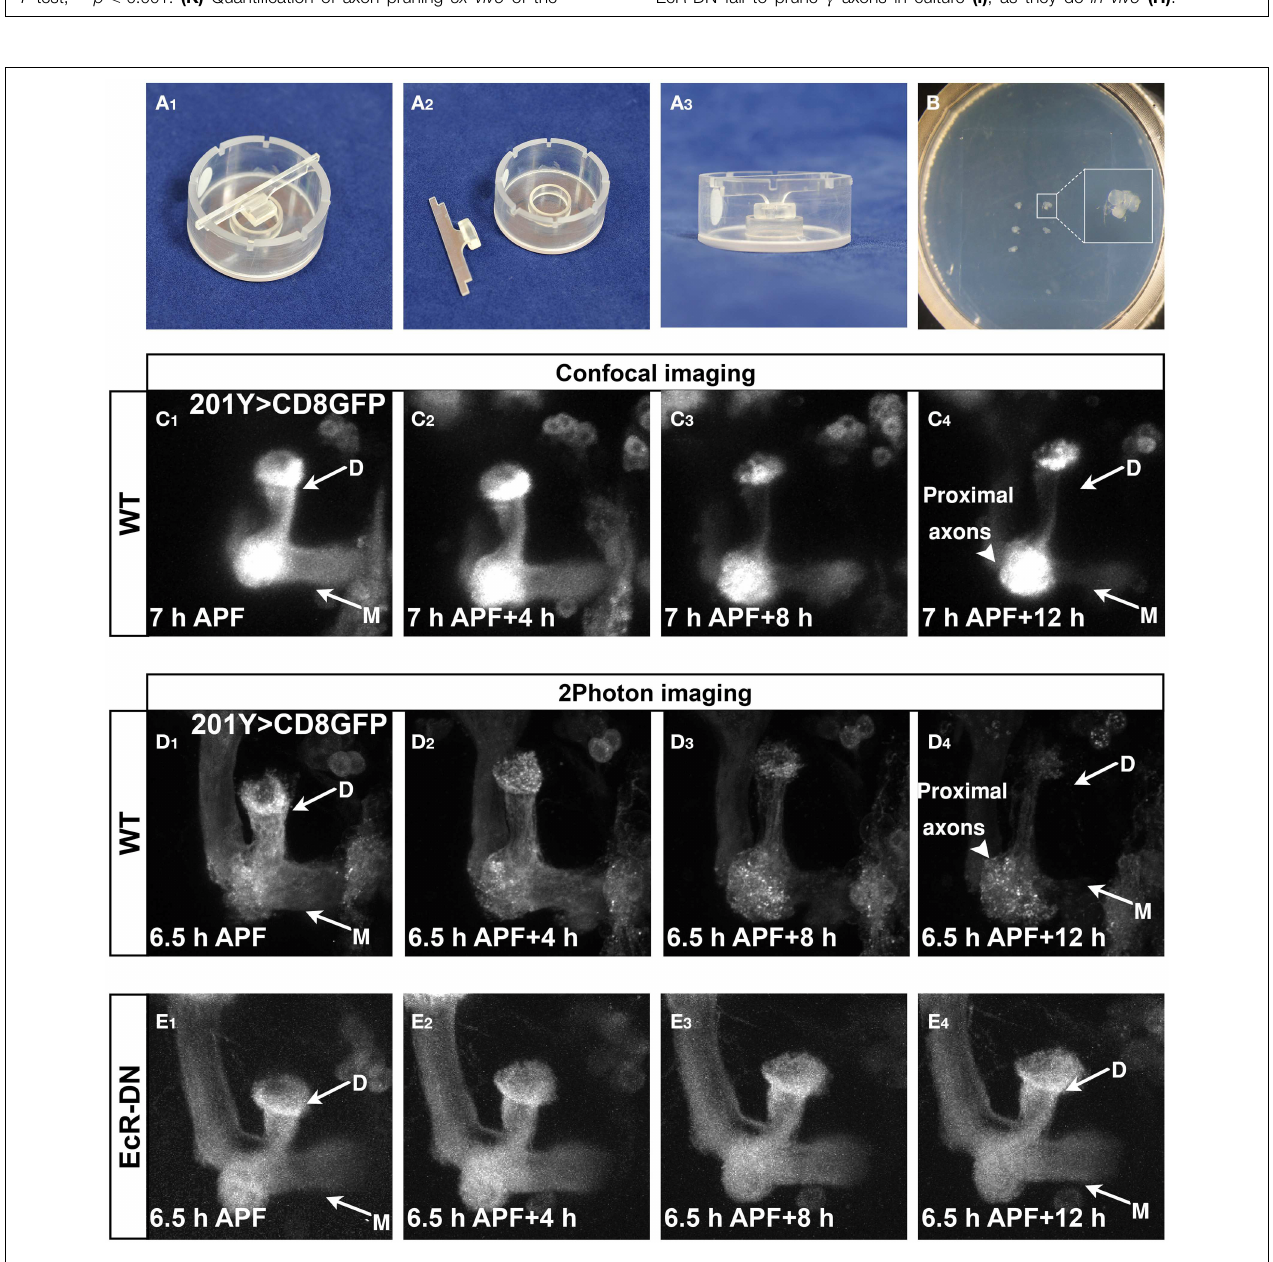
FIGURE 4 | Developmental processes, such as pruning, can be time-lapse imaged in culture. (A,B) Mounting setup (A) and mounted brains (B) , see more in the methods section and Supplemental Protocol. (C–E) Confocal (C) or two-photon (D,E) Z-stacks of images extracted from time-lapse movies of MBs labeled by mCD8-GFP driven by Gal4-201Y (C,D) or additionally expressing EcR-DN (E) in brains dissected at 6.5–7h APF and cultured for 12h (first time point— C–E 1 ,